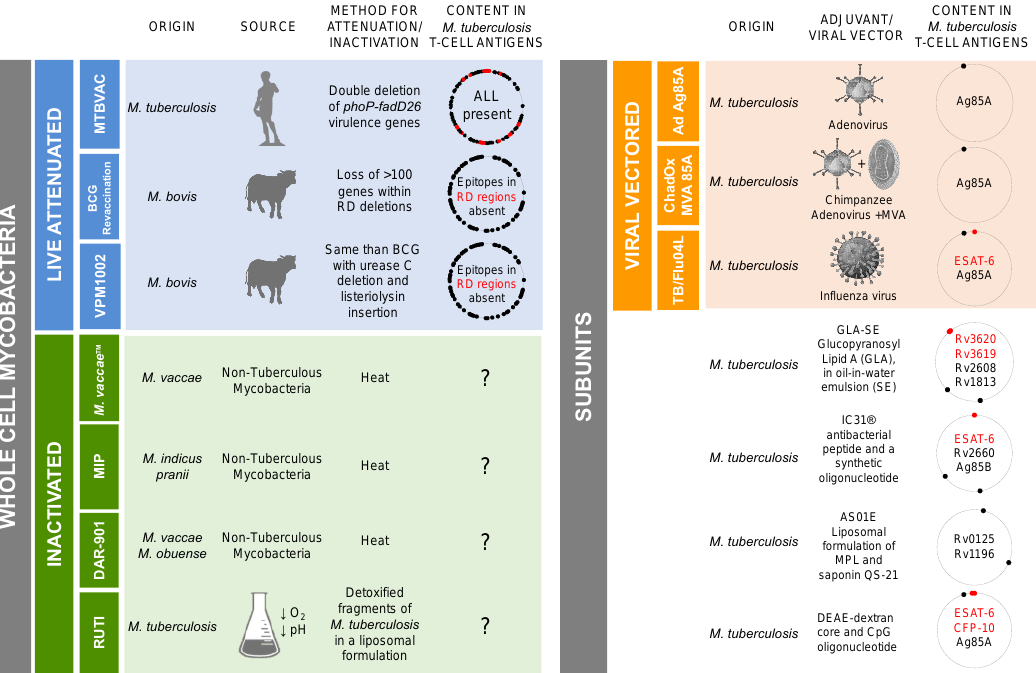
Figure 3. The diversity of TB vaccine candidates in clinical trials. Schematic table showing the main characteristics of the vaccine candidates. The table is coloured according to vaccine strategies indicated in Figure 2 and contains representative information for each candidate, including the mycobacterial origin from each vaccine and their antigenic content.